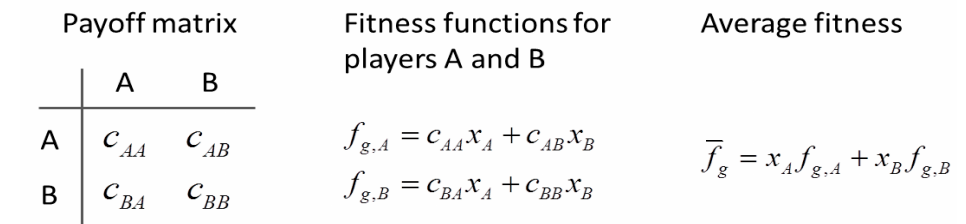
Figure 7. A simple game between players A and B: In evolutionary game theory, payoff is equated with